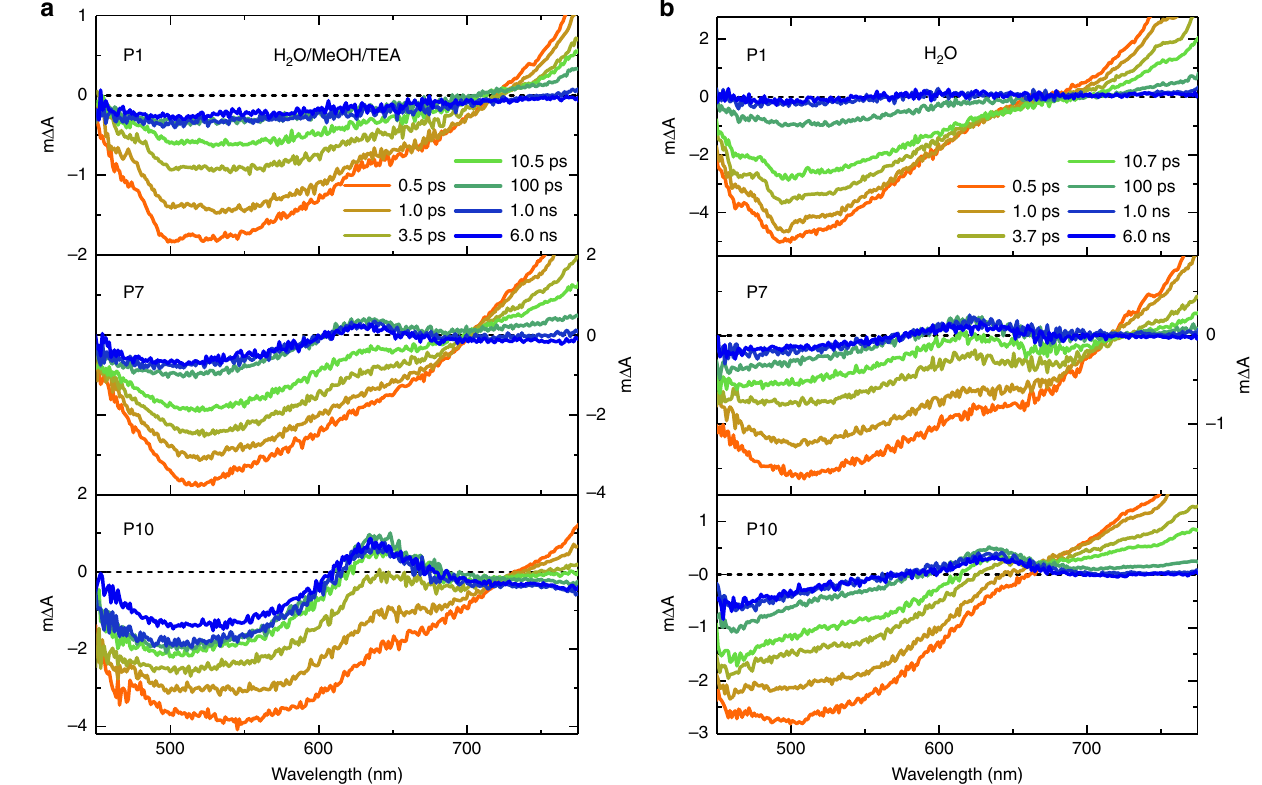
Fig. 2 Spectral signatures of photogenerated reaction intermediates on the fs – ns timescale. Transient absorption spectra obtained from suspensions of P1, P7, and P10 (from top to bottom) in a a solvent mixture consisting of equal volumes of H 2 O, MeOH, and TEA and b in H 2 O. All data were obtained using an excitation wavelength of 355 nm and a fl uence of 0.08 mJ cm −